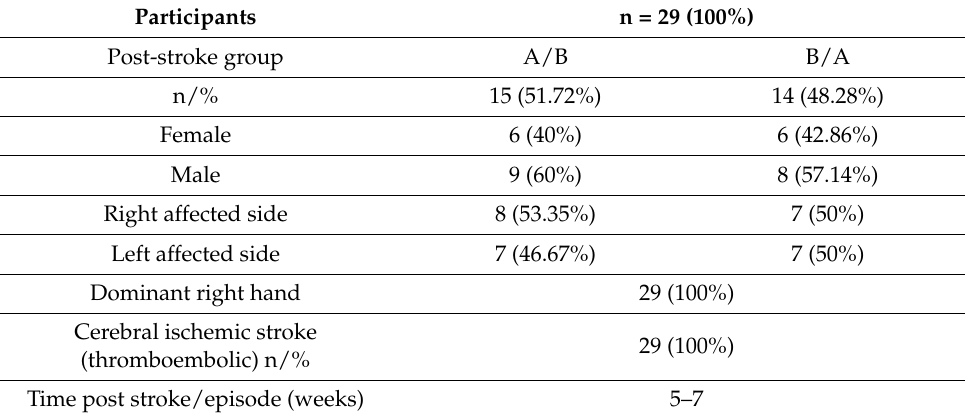
Table 2. The basic epidemiological data of the study population and the clinical control